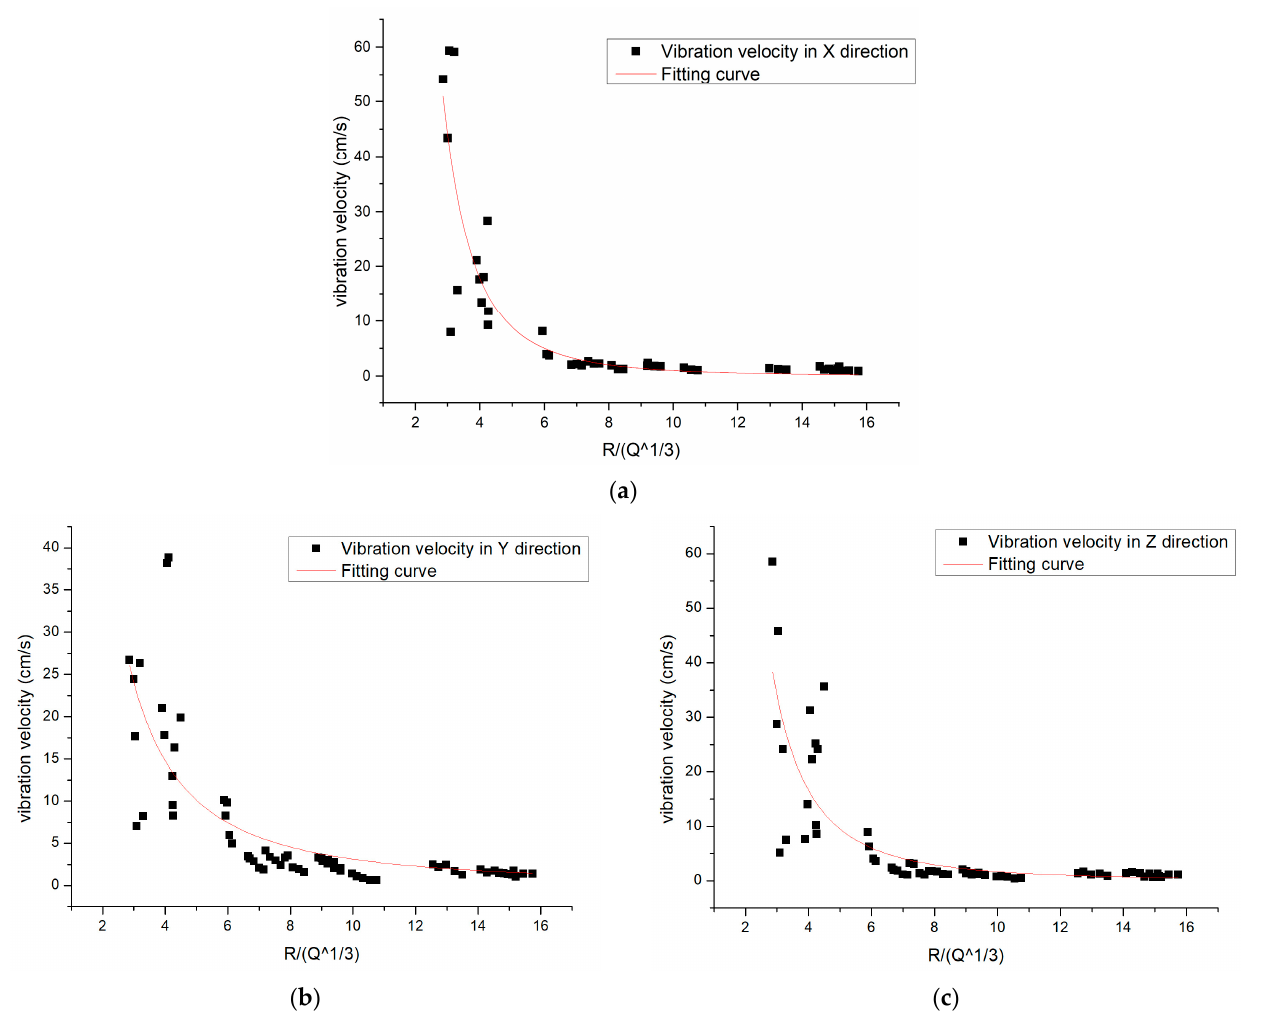
Figure 3. Vibration velocity in three directions of cutting hole blasting in front of the working face: